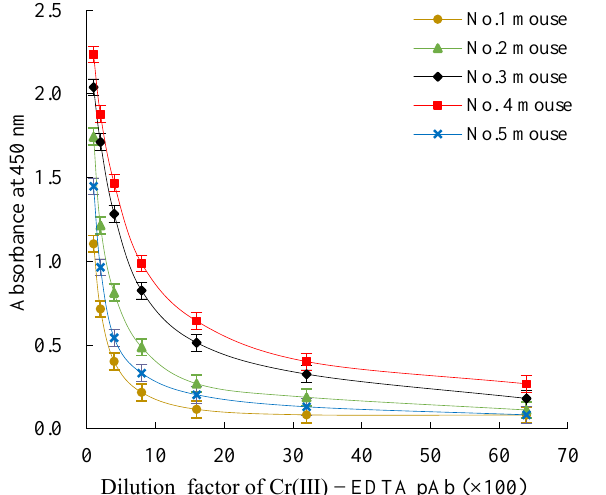
Figure 2. The inELISA titers measurement for Cr(III)-EDTA pAb. InELISA: indirect non-competitive ELISA. Cr(III)-EDTA: Cr(III) is chromium trivalent ion, EDTA is chelating agent ethylenediamine tetraacetic acid, and Cr(III)-EDTA is a chelate of Cr(III) and EDTA. pAb: polyclonal antibody.